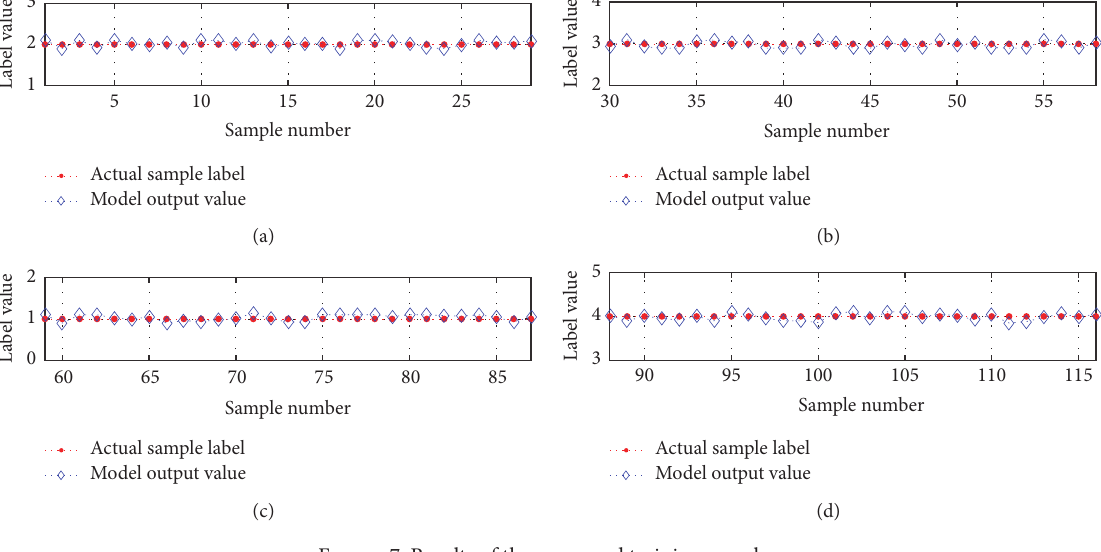
Figure 7: Results of the processed training